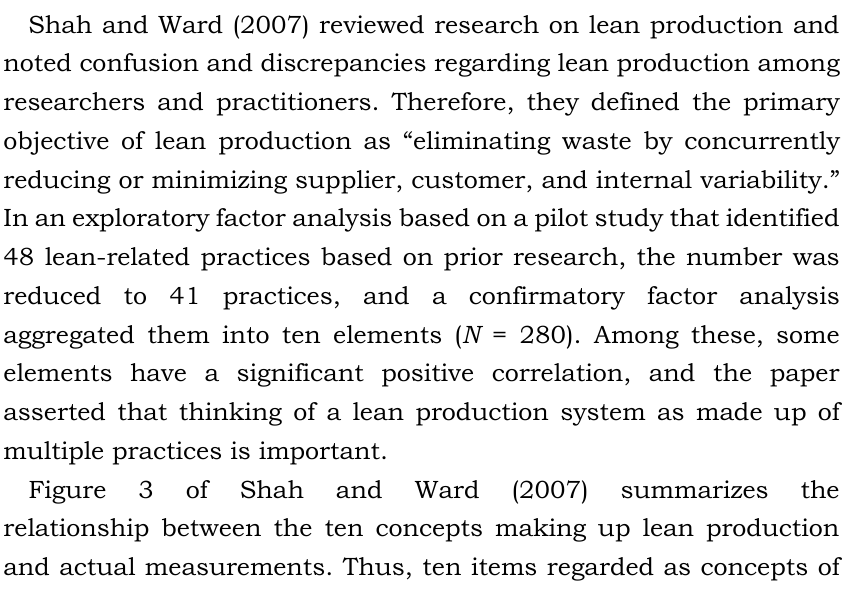
Figure 3 of Shah and Ward (2007) summarizes